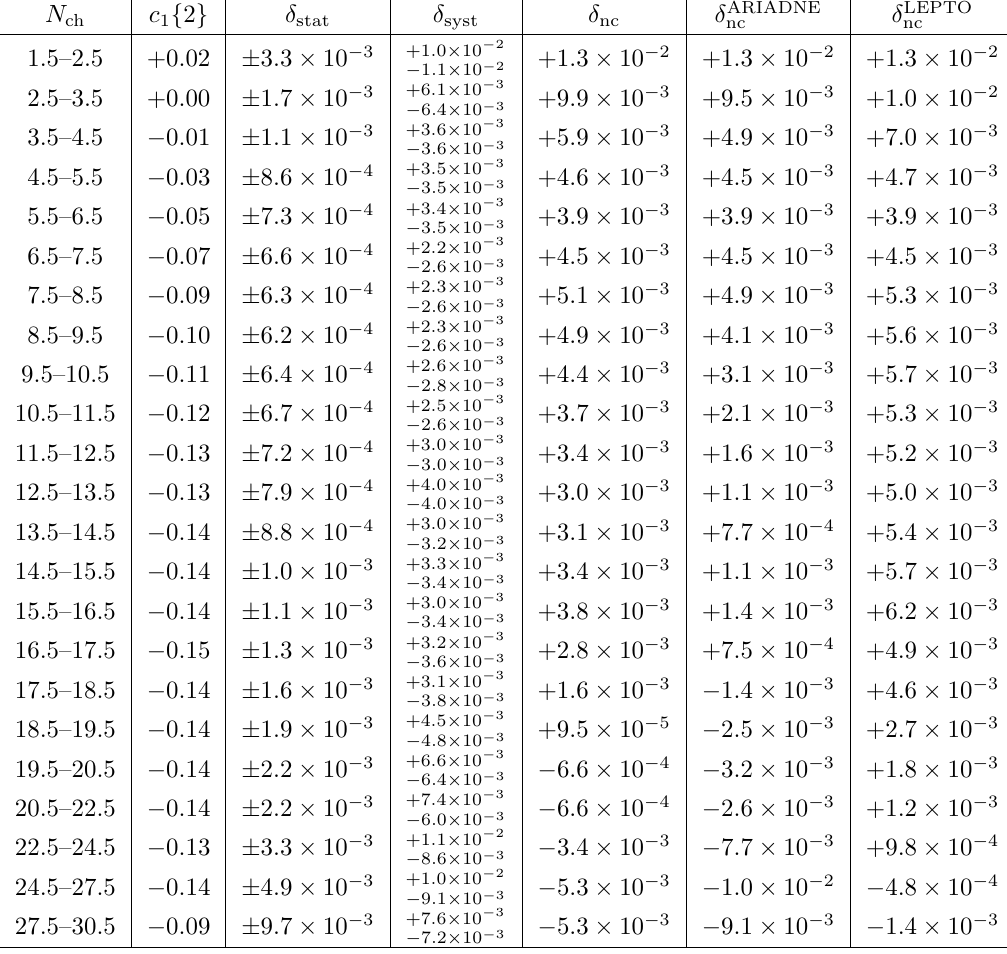
Table 3 . c 1 f 2 g versus N ch from (cid:12)gure 7 (a) and (cid:12)gure 10 (c), p T > 0 : 5 GeV, j (cid:1) (cid:17) j > 2; (cid:14) stat , (cid:14) syst and (cid:14) nc denote the statistical, systematic and Monte Carlo non-closure uncertainties,